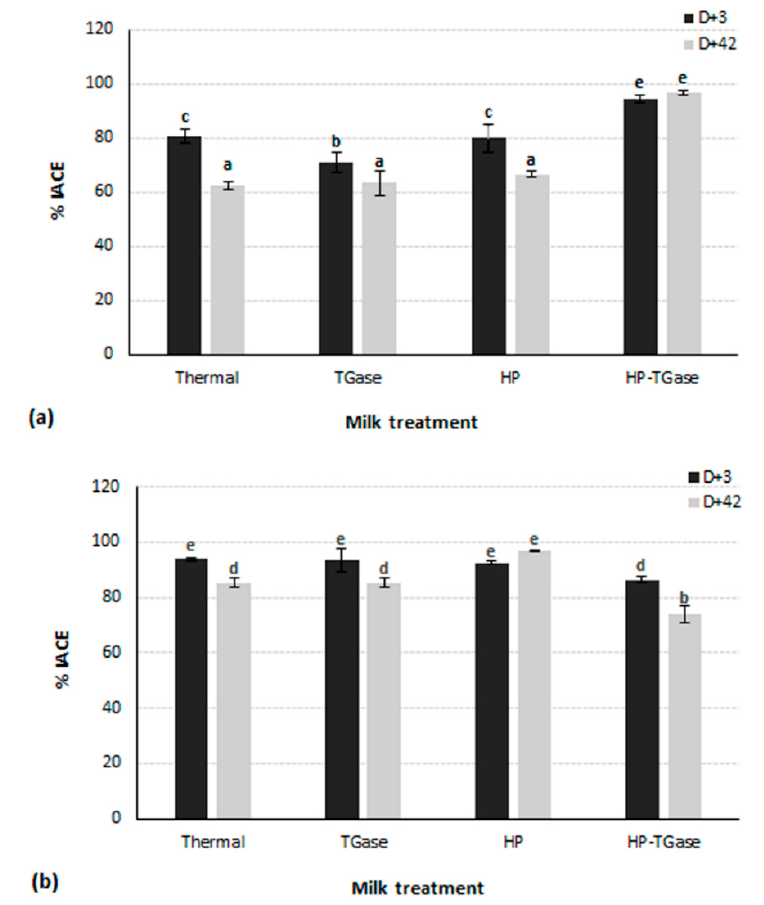
Figure 2. Anti-hypertensive properties of bovine ( a ) and ovine ( b ) water-soluble enzymes (WSEs), as expressed though the % angiotensin converting enzyme inhibitory activity (% IACE). Different letters among bars indicate significant differences ( p < 0.05) between tested samples according to Duncan’s mean values post hoc comparison test.